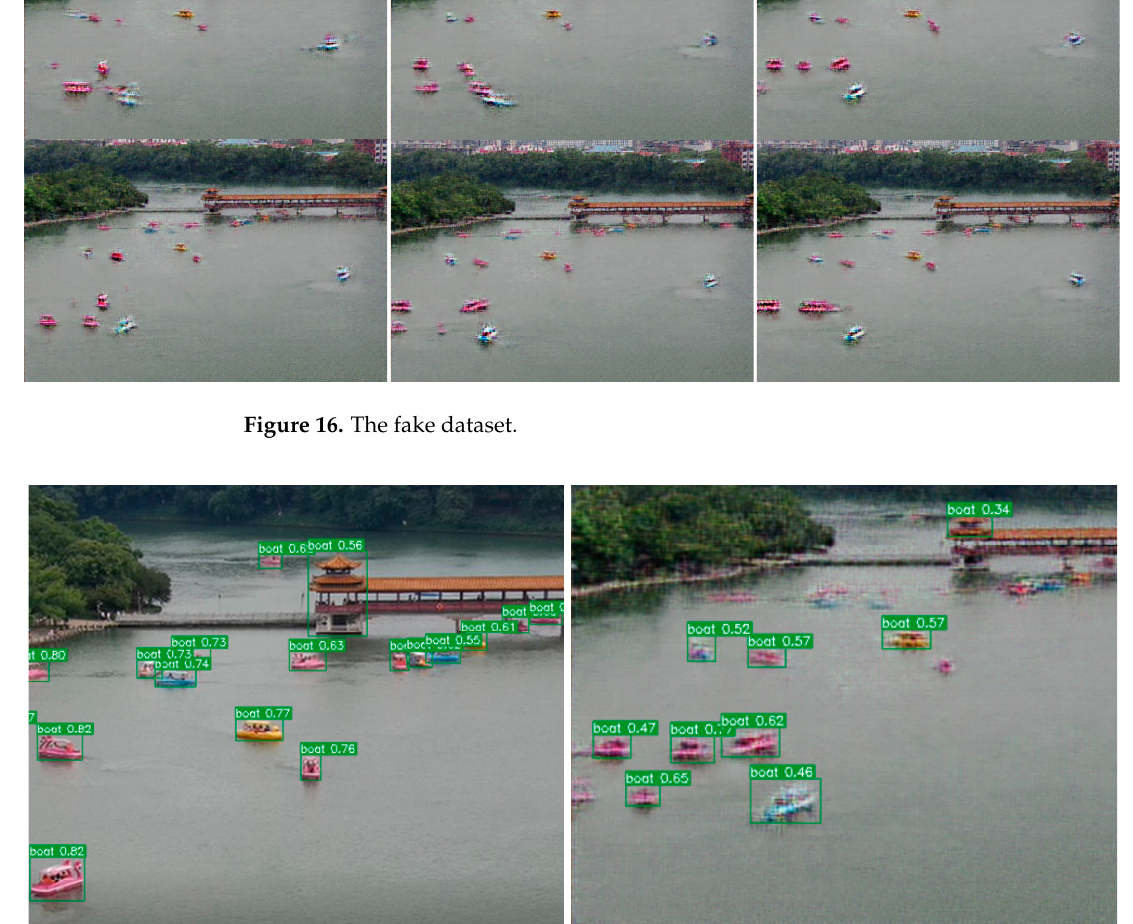
Figure 17. Detection results displayed after the enhanced model.